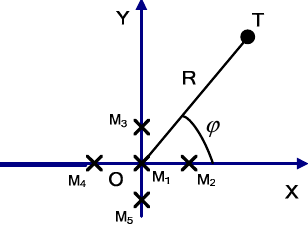
Figure 1. Model of single array.